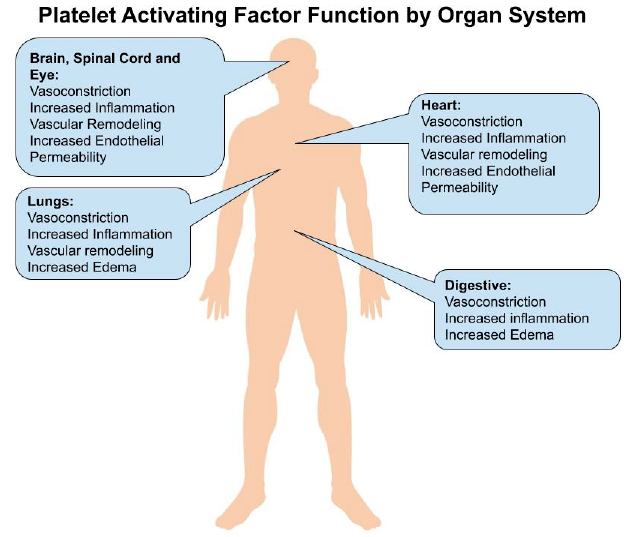
Figure 5. Summary of the function of PAF within each body system.